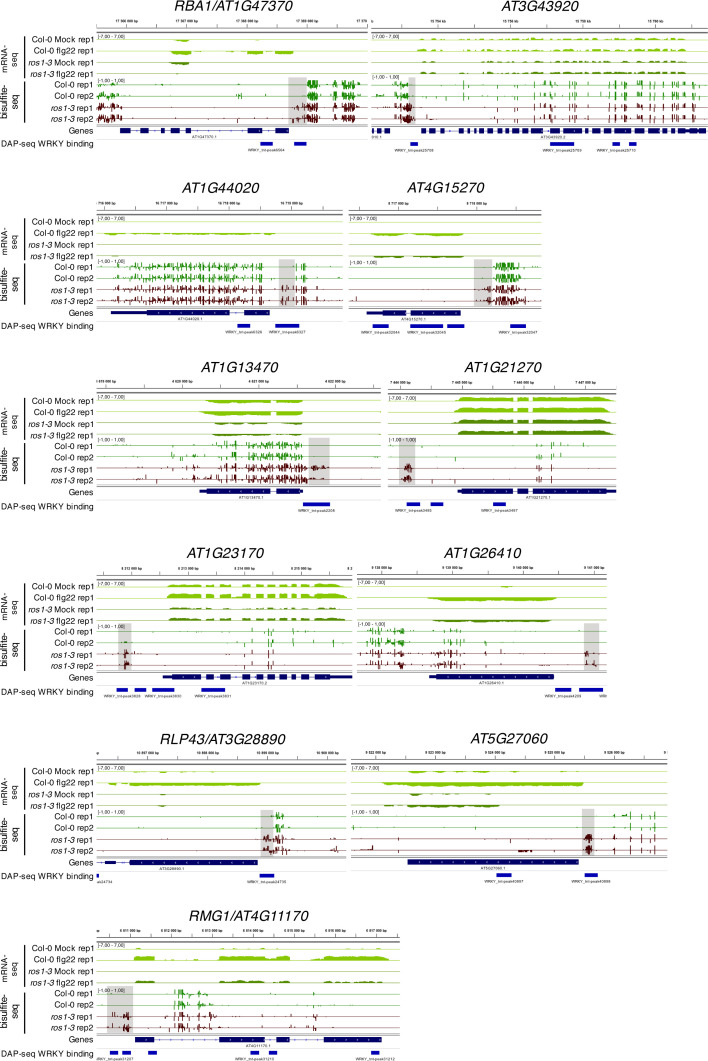
Position of WRKY DNA binding peaks at the 11 flg22-induced ROS1 targets.Snapshots depicting RNA-seq (rep1), BS-seq (rep1 and rep2), and the position of WRKY-binding sites observed in the DNA affinity purification sequencing (DAP-seq) data (O'Malley et al., 2016) in Col-0 and ros1-3 untreated rosette leaves.